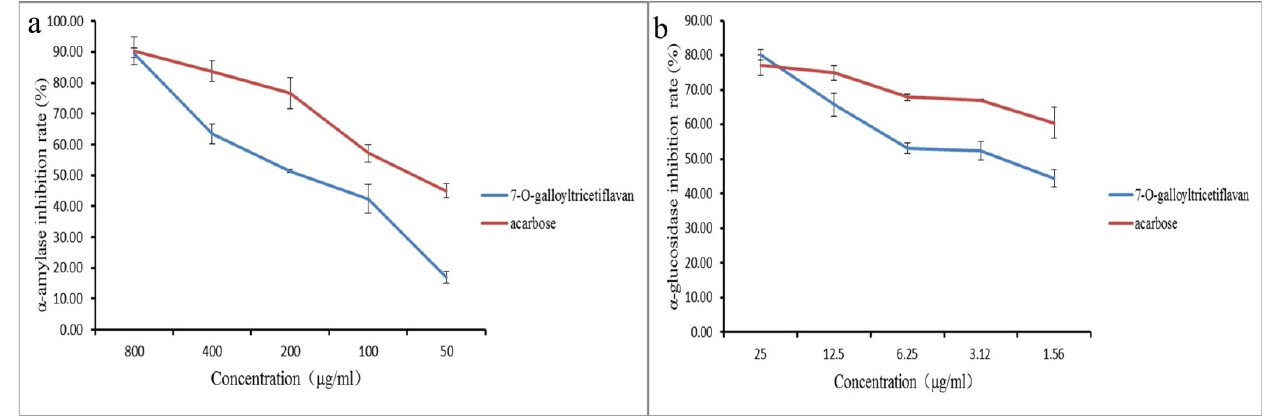
Figure 6. α -Amylase and α -glucosidase inhibition rates of 7-O-galloyltricetiflavan and acarbose. ( a ) Inhibition rate of α -amylase; ( b ) inhibition rate of α -glucosidase.